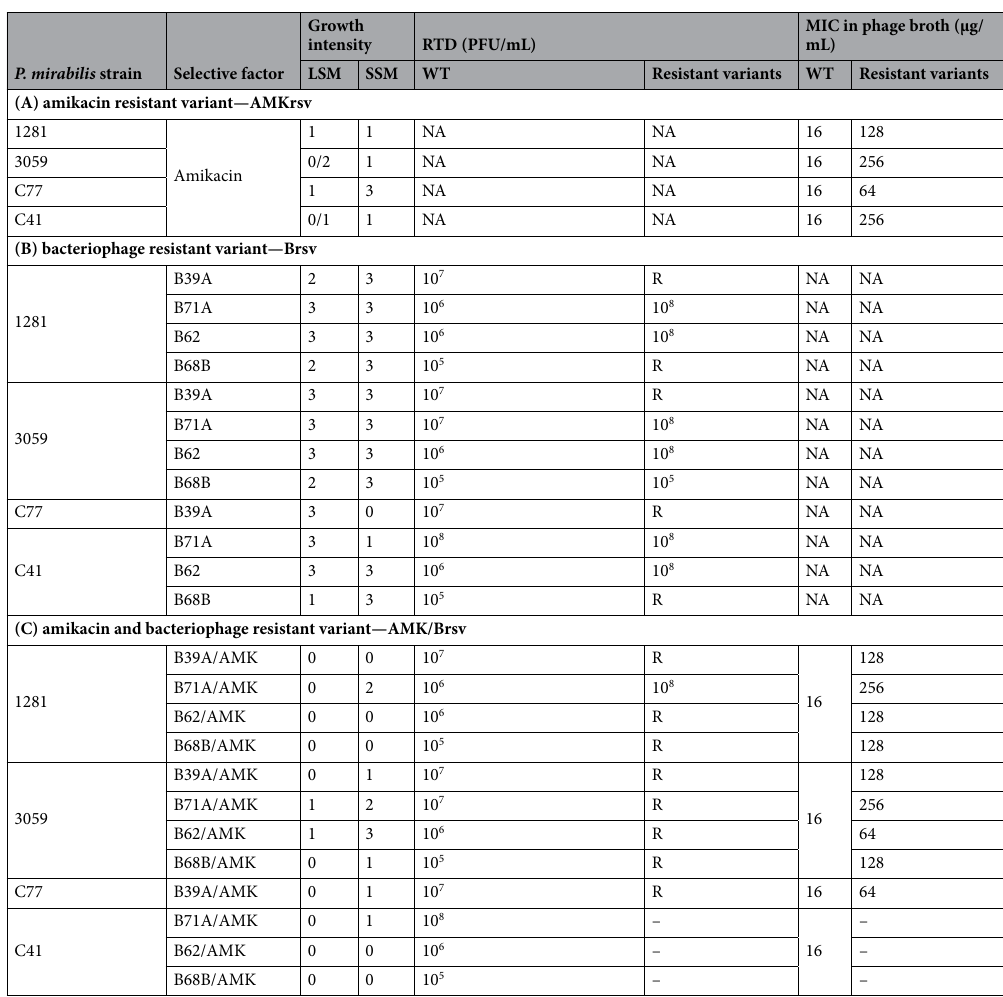
Table 1. Proteus mirabilis amikacin resistant variant—AMKrsv (A), bacteriophage resistant variant—Brsv (B) and amikacin and bacteriophage resistant variant—AMK/Brsv (C) selection for outer membrane